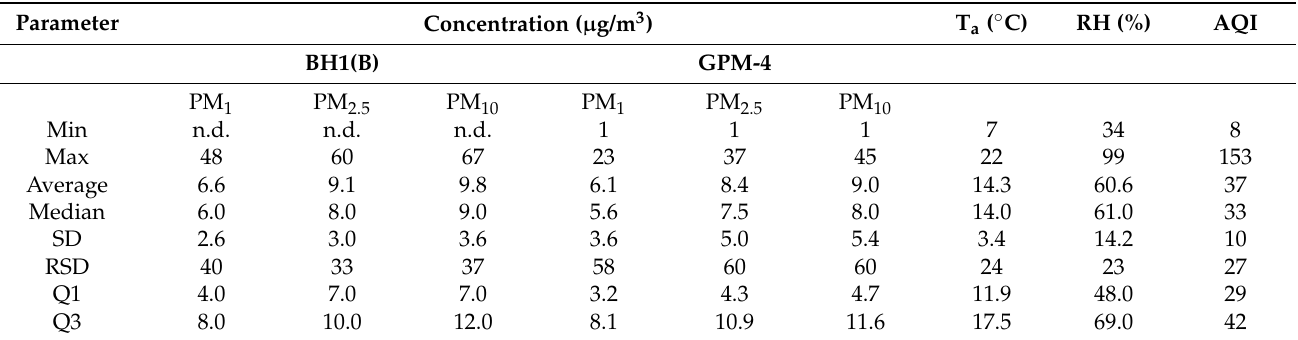
Table 5. Statistics of air monitoring data for GPM and BH1 sensors collected outdoors at the